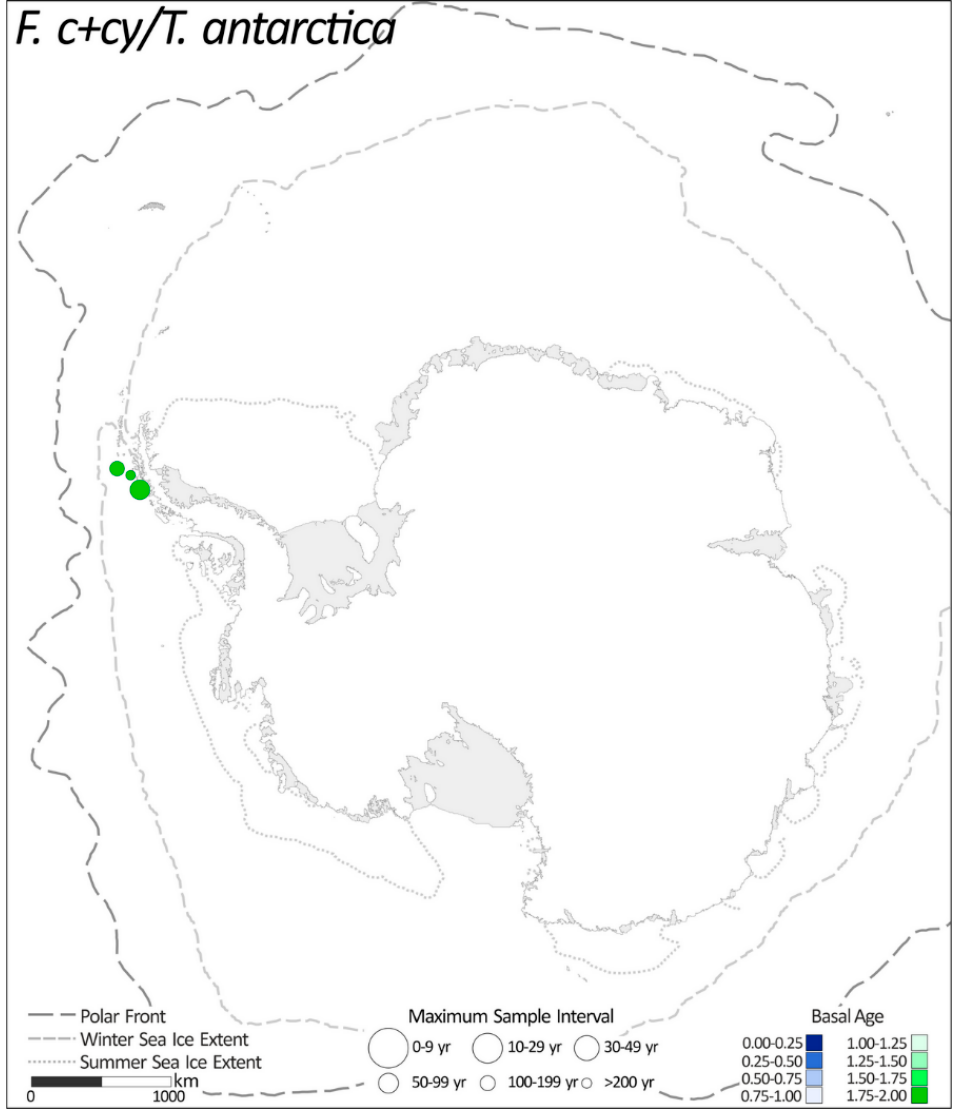
Figure 4. Map showing cores sites where F. c + cy / T. antarctica is used to reconstruct sea ice conditions. The symbol size reflects the resolution of the record and the color of the symbol indicates the basal age of the record between 0 and 2 ka BP.